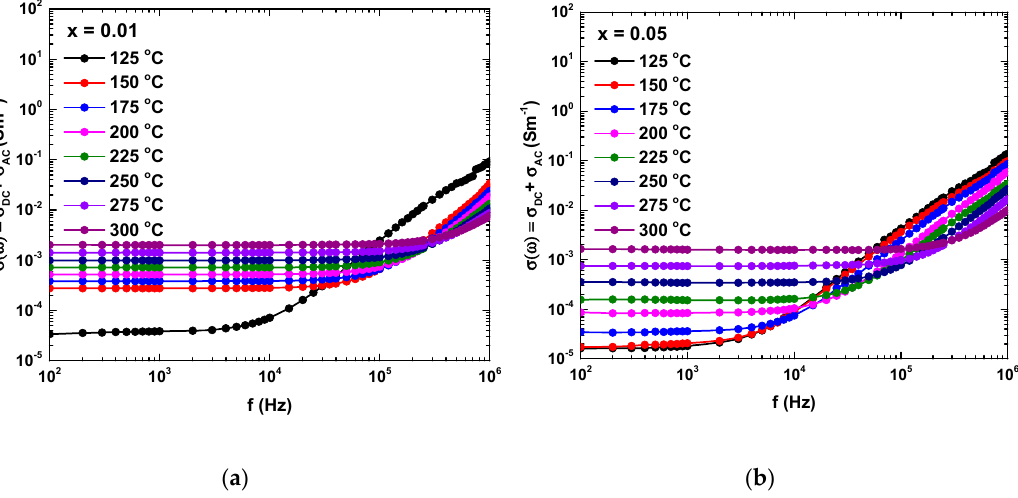
Figure 9. Complex conductivity, σ (f), of LaFe 1 − x Zr x O 3 with ( a ) x = 0.01 and ( b ) x = 0.05 annealed at 800 °C for 6 h at different temperatures.